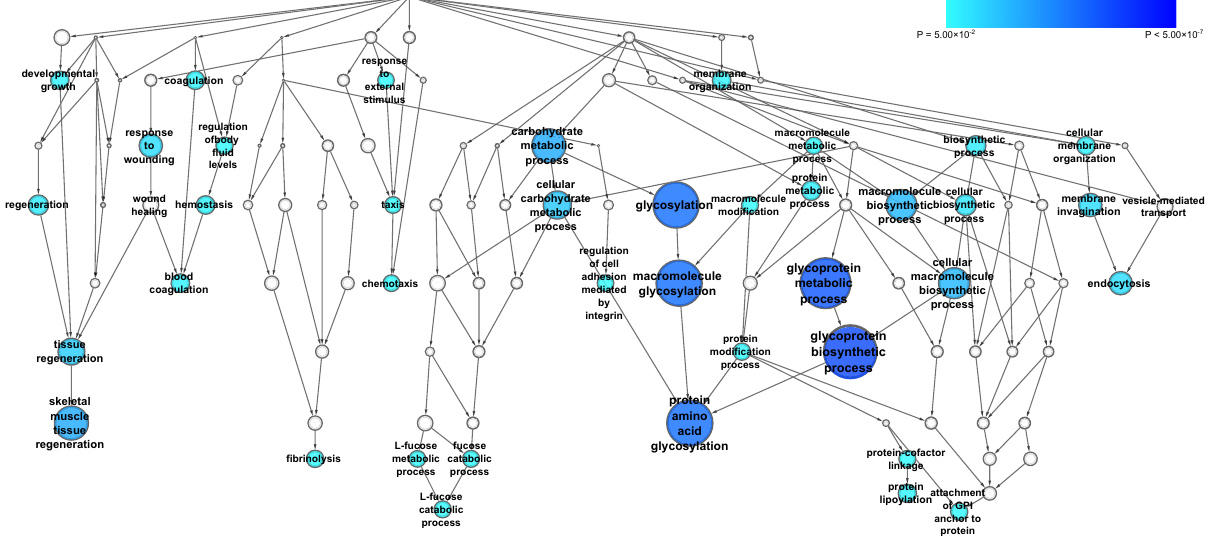
Fig. 2 Results of the BiNGO pathway over-representation analysis for GO biological processes, using the 12 genes found from the suPAR GWAS meta- analysis. Signi fi cant overrepresented pathway gene sets ( P < 0.05 after surviving Benjamini & Hochberg False Discovery Rate correction) are shaded blue with size and darker shades signifying lower P -values as depicted in the